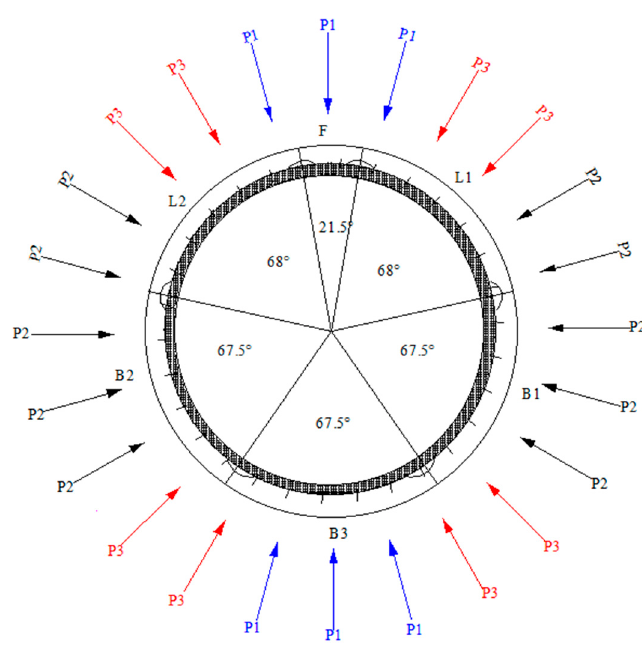
Figure 8. Distribution of circumferential loading points.